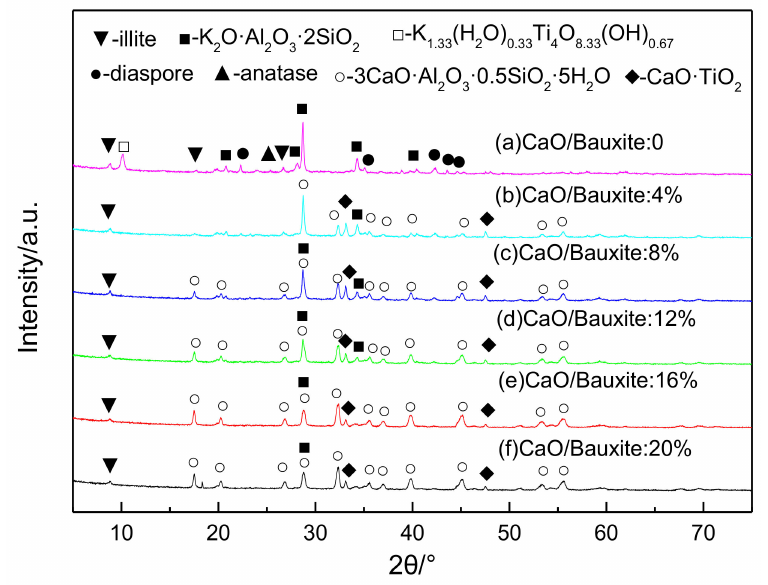
Figure 3. XRD patterns of red mud with different mass ratios of CaO/bauxite (conditions: ρ (K 2 O) = 254 g/L, T = 265 ◦ C, t = 1 h).